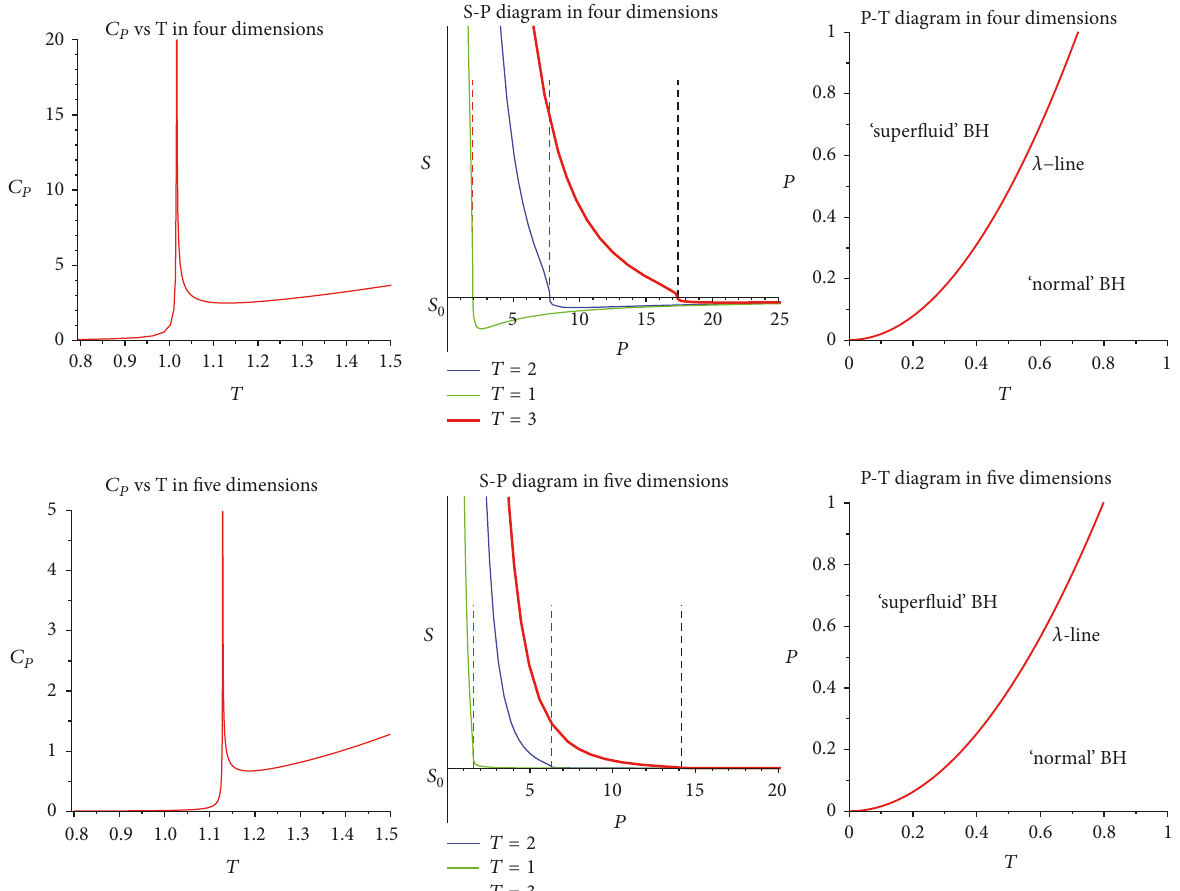
Figure 3: Curves of 𝐶 𝑃 − 𝑇 and 𝑆 − 𝑃 and 𝑃 − 𝑇 parameter space of black holes with 𝜖 = 𝜖 𝑐 in four and five dimensions. The 𝜆 line in 𝐶 𝑃 − 𝑇 and 𝑃 − 𝑇 plots indicates the second-order phase transitions between “superfluid” black hole phase and “normal” black hole phase, which are distinguished in the 𝑆 − 𝑃 plots by the dashed